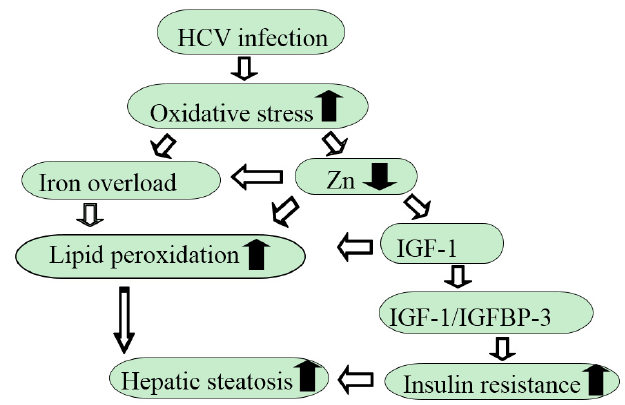
Figure 2. Putative mechanisms by which chronic HCV infection evokes insulin resistance and hepatic steatosis. hepatic